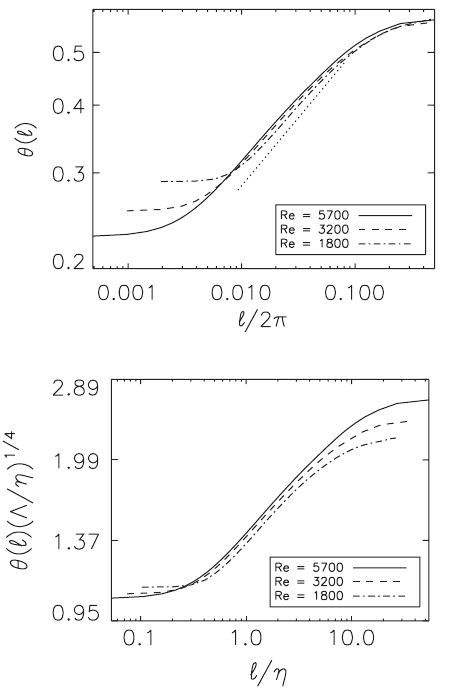
FIG. 7. Measurements of the dynamic alignment angle (4) in balanced RMHD. The frames show numerical simulations with an increasing Reynolds number and numerical resolution with properly resolved dissipation ranges [runs RB1c (dash-dotted line), RB2c (dashed line), and RB3d (solid line)]. In the lower plot, the scale l is rescaled by the dissipation length (see section VI for precise definitions). It can be seen from here that the region of scale-dependent dynamic alignment increases as smaller scales are made available by increased numerical resolution. The extent of the alignment region is not limited by the dissipation scale, but rather depends on the grid size of the numerical scheme. The straight dotted line has the slope 1 = 4